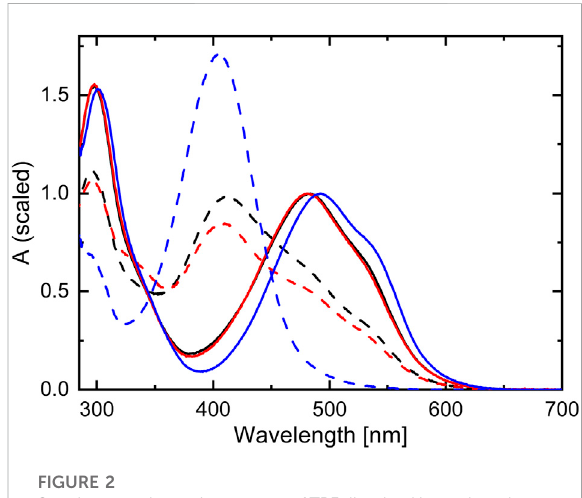
FIGURE 2 Steady-stateabsorptionspectraofTPF dissolvedinmethanol (black), acetonitrile (red), and toluene (blue). The solid curves display the ground-state absorption spectra (normalized to the maximum around 500 nm), while the dashed spectra correspond to the photostationary state under illumination with 520 nm